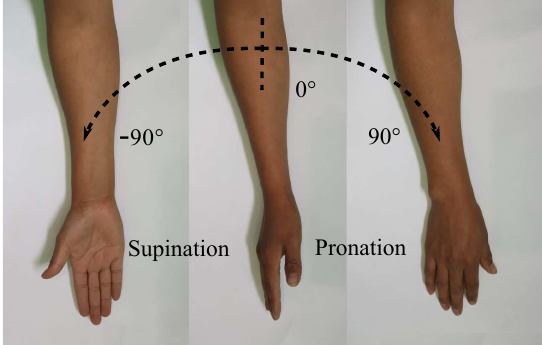
Figure 1. Supination–pronation of the entire ROM.